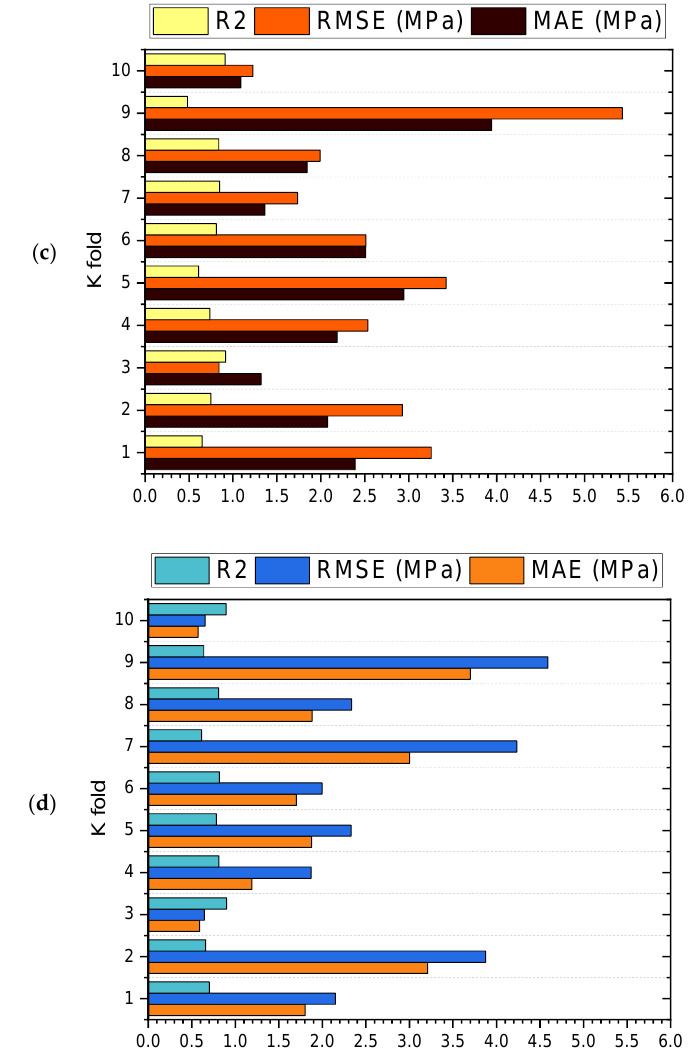
Figure 12. ( a ) AdaBoost; ( b ) bagging; ( c ) gradient boosting; and ( d ) extreme gradient boosting statistical representation.